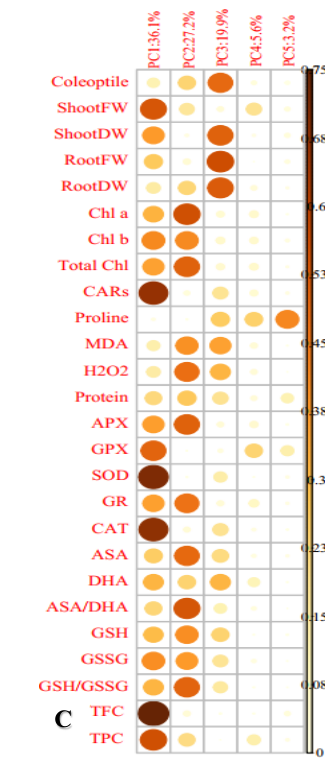
Figure 6. Heat map ( A ), loading biplot of the evaluated traits ( B ) and principal component analysis heat map ( C ) of the enzymatic and non-enzymatic antioxidants pool, the morphological and the biochemical changes in Cucurbita sp. genotypes under induced-osmotic stress by mannitol and PEG application in in vitro condition. Heat map representing of Coleoptile length, Shoot and Root FW and DW, Chlorophyll a (Chl a), Chlorophyll b (Chl b), Total chlorophyll (Total Chl), Carotenoids (CARs), Proline content, Malondialdehyde (MDA), H2O2 content, Total soluble protein content, Guaiacol peroxidase (GPX) activity, Ascorbate peroxidase (APX) activity, Superoxide dismutase (SOD) activity, Reduced ascorbate (AsA), Rehydroascorbate (DHA), AsA/DHA, Reduced glutathione (GSH), Oxidized glutathione (GSSG), GSH/GSSG, Total flavonoids content (TFC) and Total phenol content (TPC).